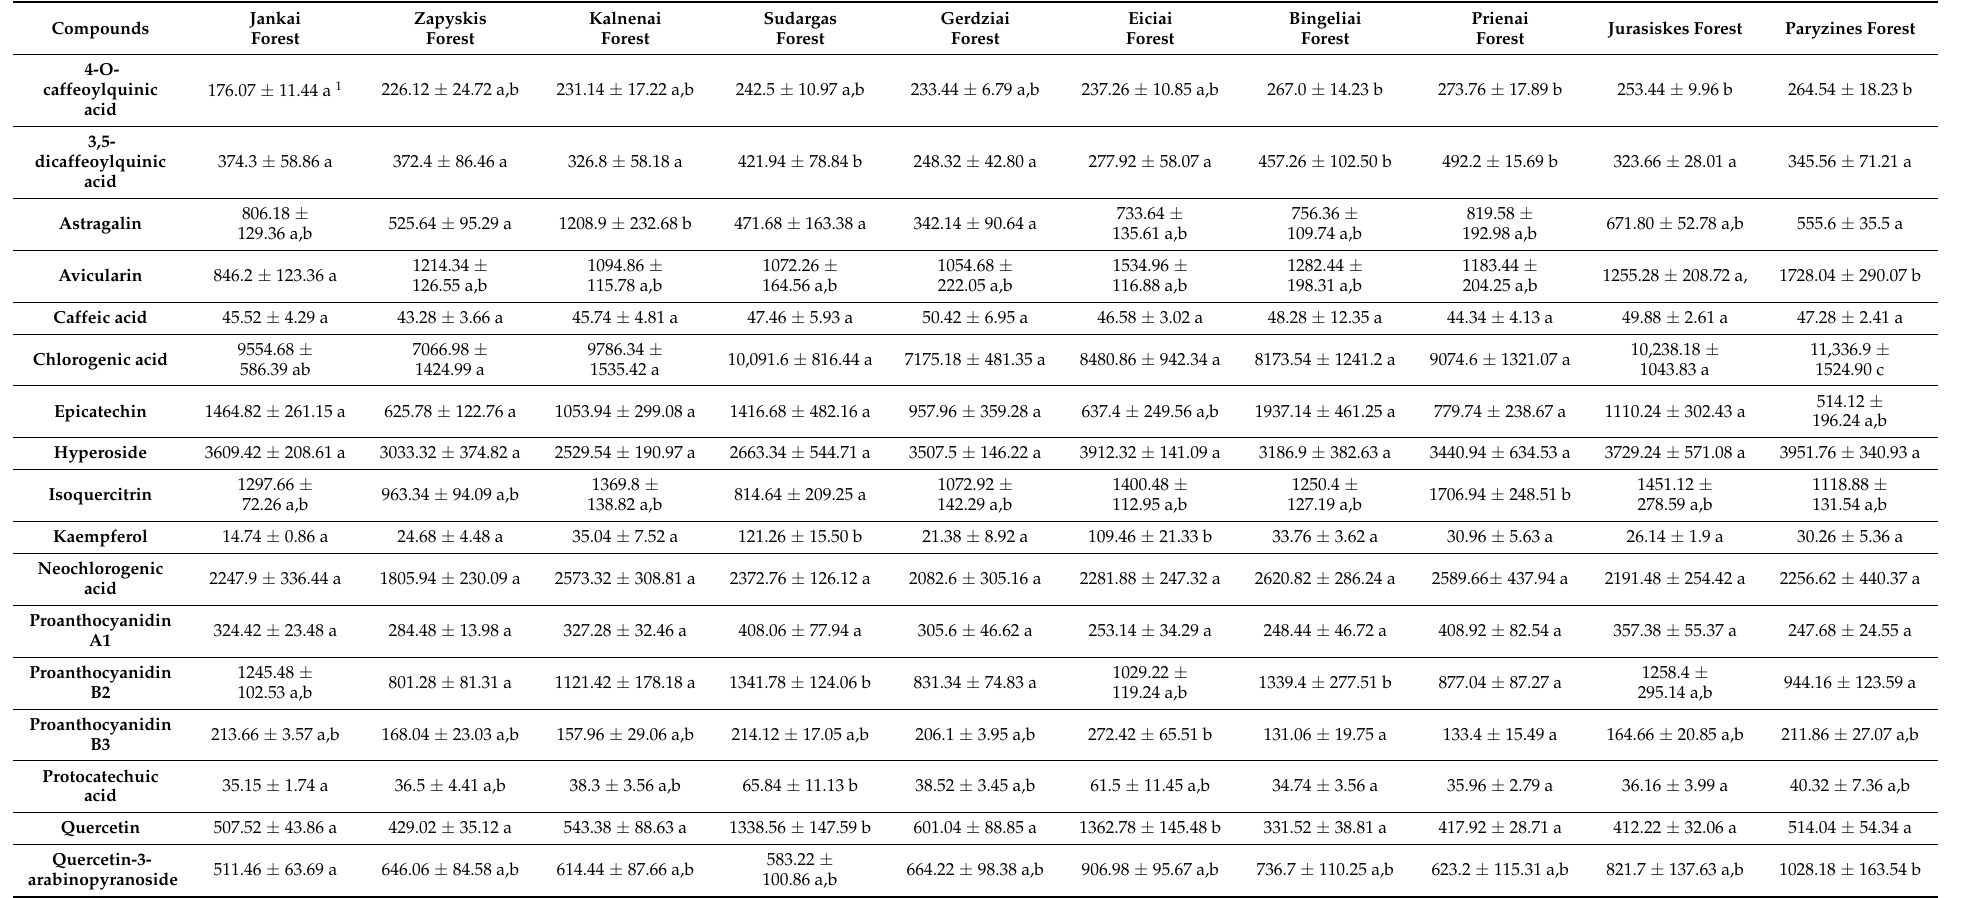
Table 1. Diversification of phenolic compounds in different heather habitats ( µ